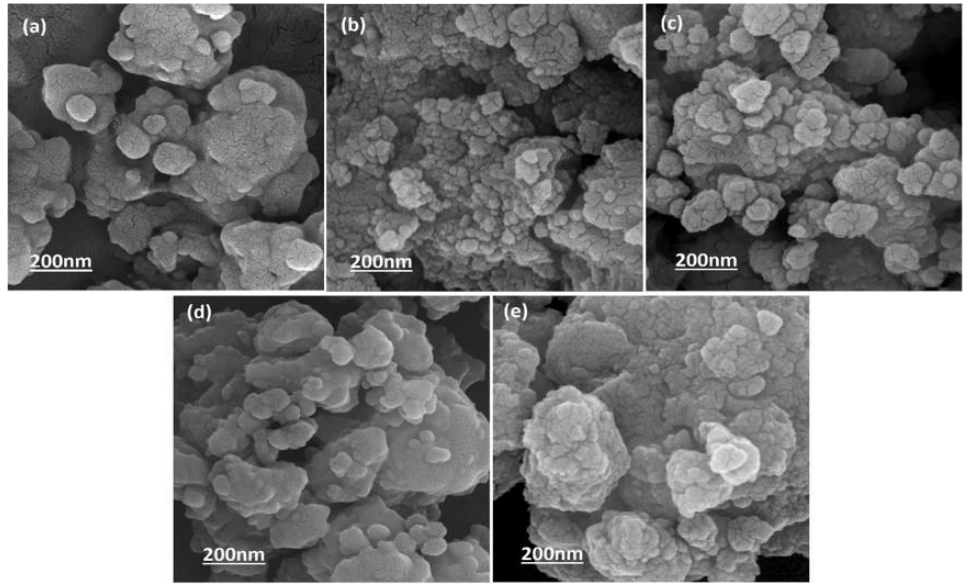
Figure 3. FE-SEM micrograph of: ( a ) HA. ( b ) HA-0.5Li. ( c ) HA-1Li. ( d ) HA-2Li. ( e ) HA-4Li powder before sintering.